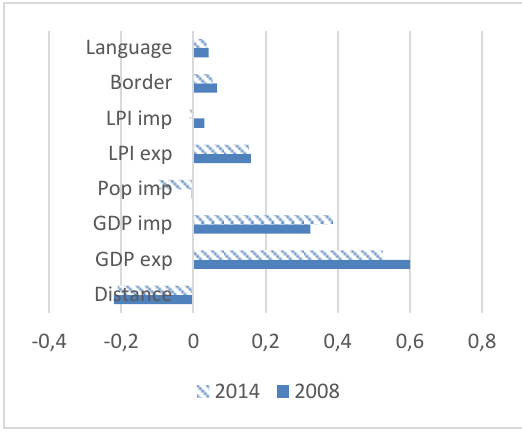
Figure 1. Significant Determinants of Value Added in Exports for UE-28 Economies